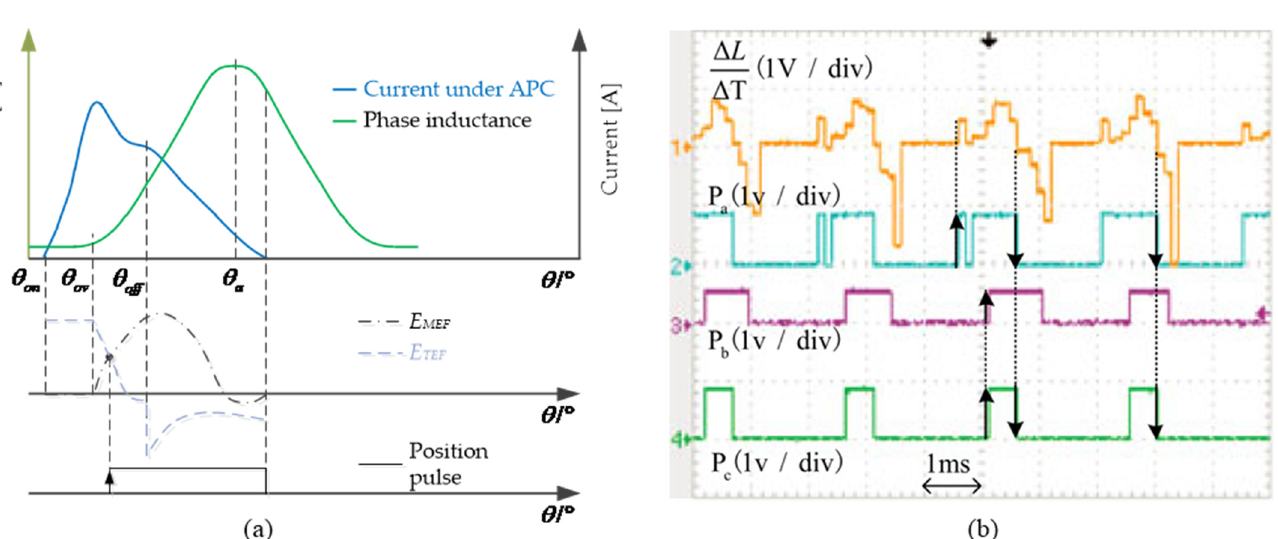
Figure 12b. To use fewer sensors, the bus current is decomposed, and the current gradient is then used to estimate the rotor position [149]. The theoretical basis is to expand Equation (3) to obtain Equation (12).